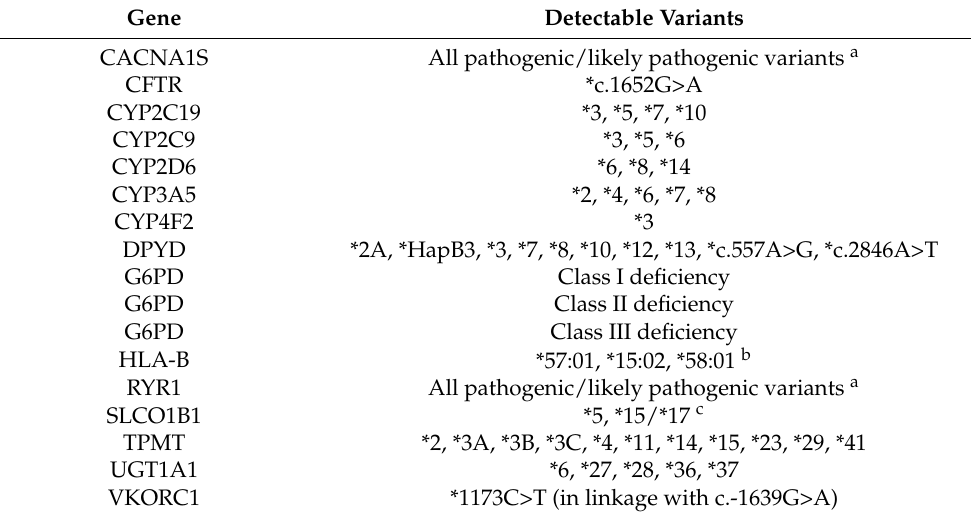
Table A1. Genes and Variants Detectable from Whole-Exome